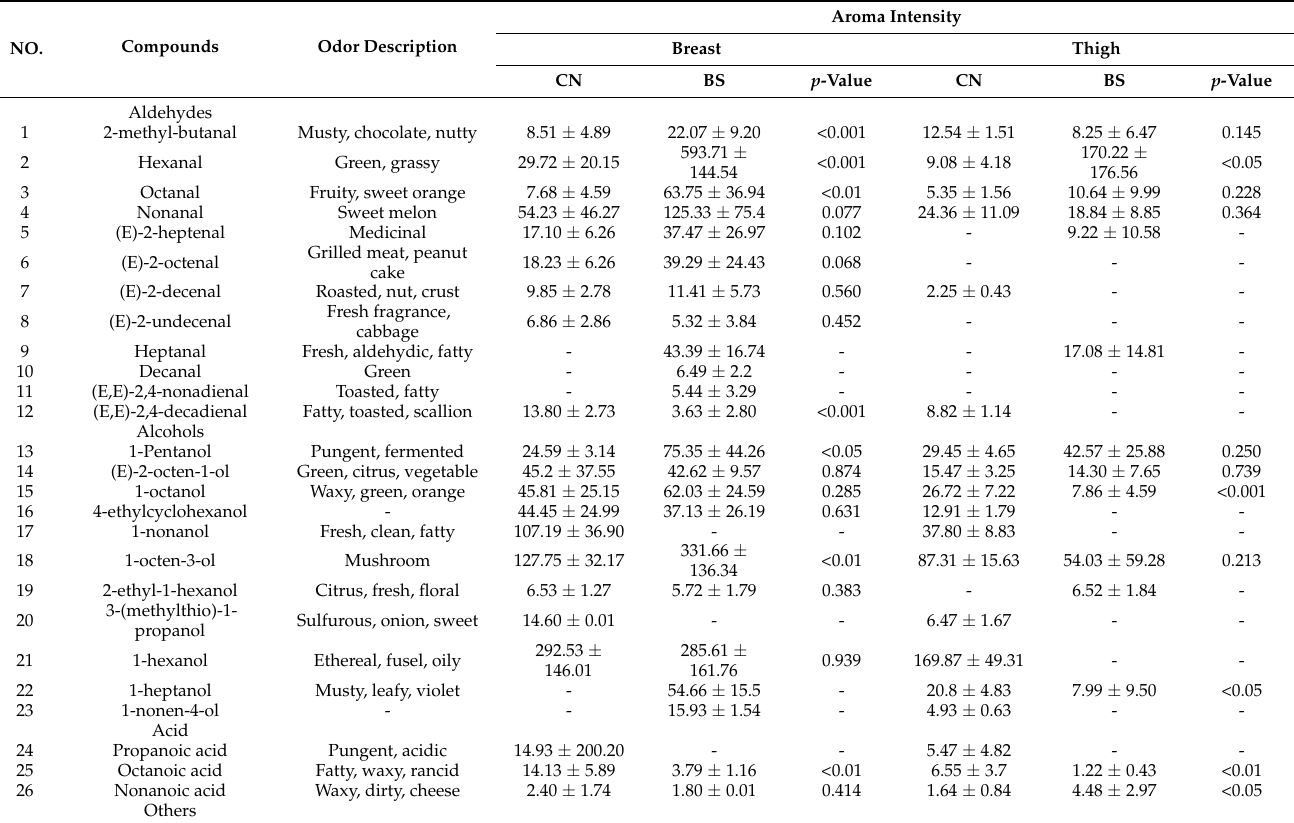
Table 7. Effects of dietary Brevibacillus laterosporus S62-9 on the volatile compounds of chicken meat ( µ g/kg chicken